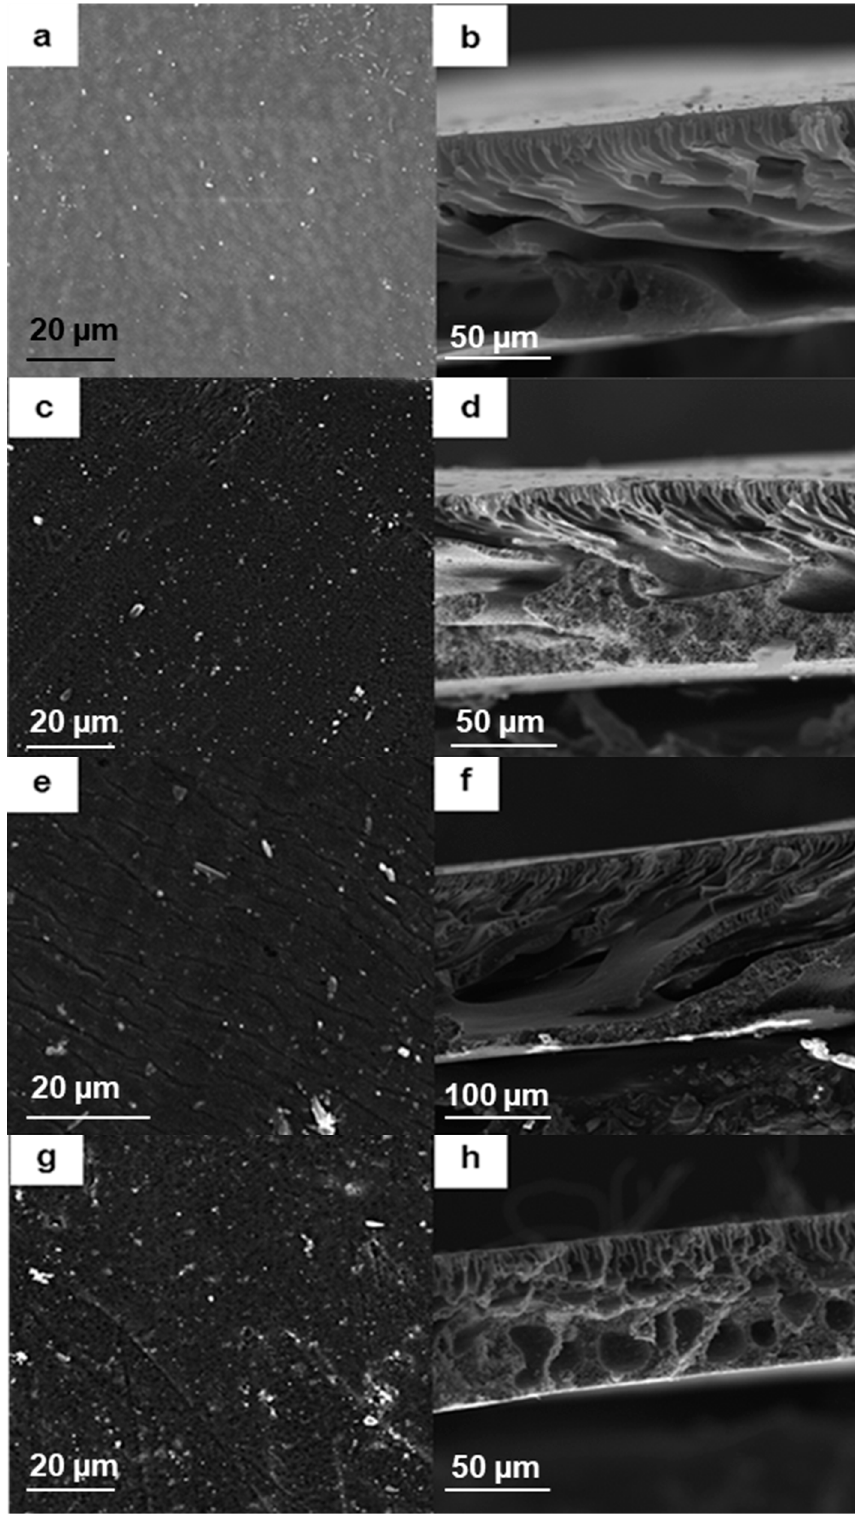
Figure 5. SEM images showing the respective surface and cross-sectional morphology of the membranes: ( a , b ) Pure PES; ( c , d ) A0; ( e , f ) A1; and ( g , h ) A2.